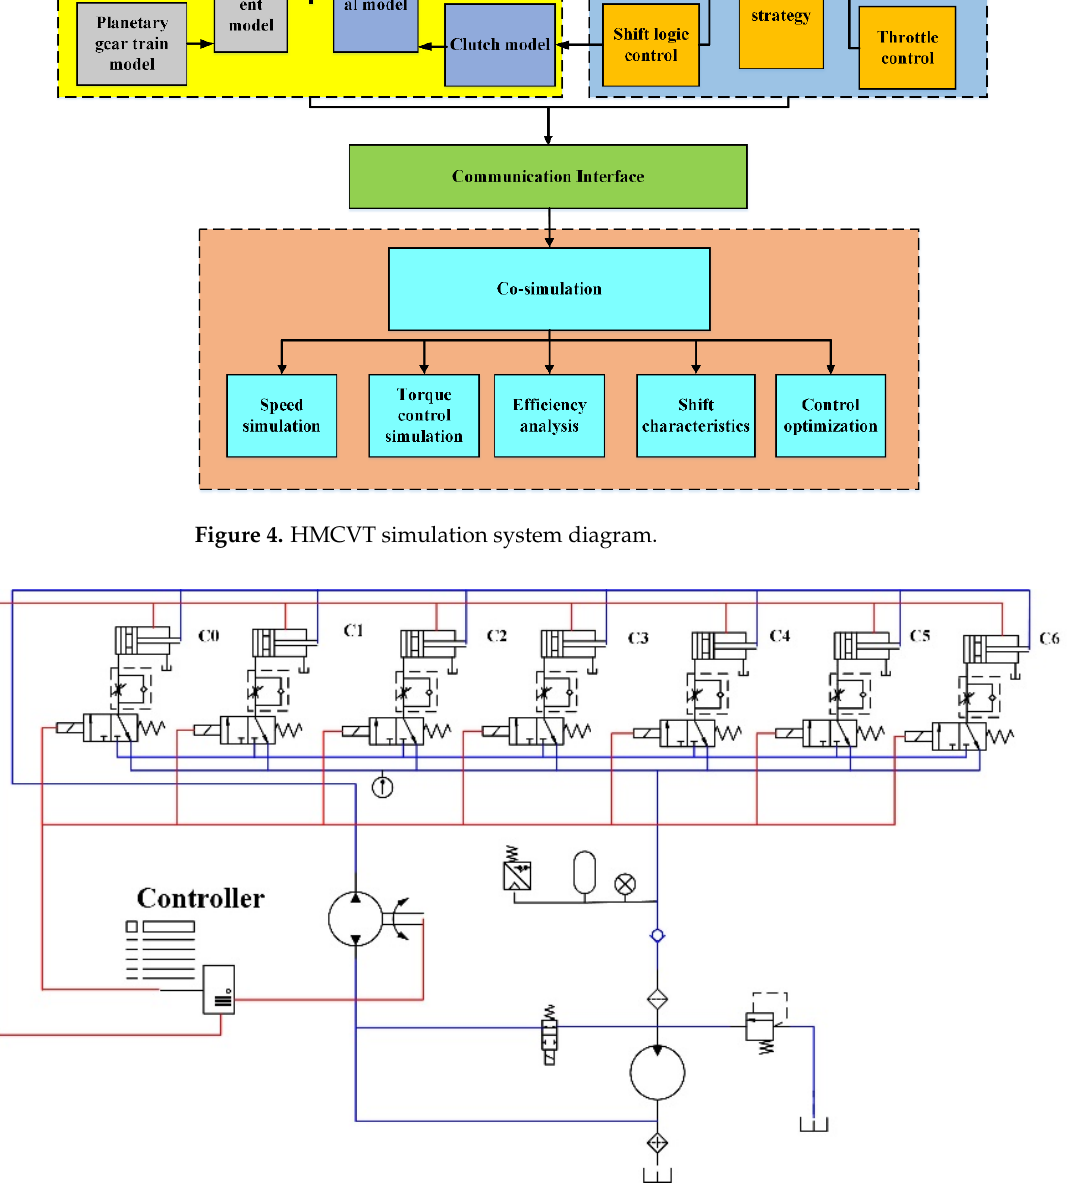
Figure 5. Clutch system control principle diagram.